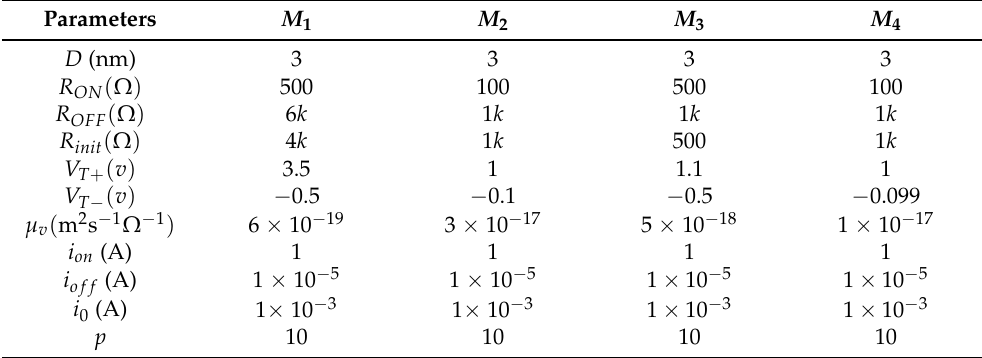
Figure 2. The change in memristance when the memristors are applied by different voltages. V in represents input voltage. M represents the memristance of memristor. Table 1. Parameters setting of